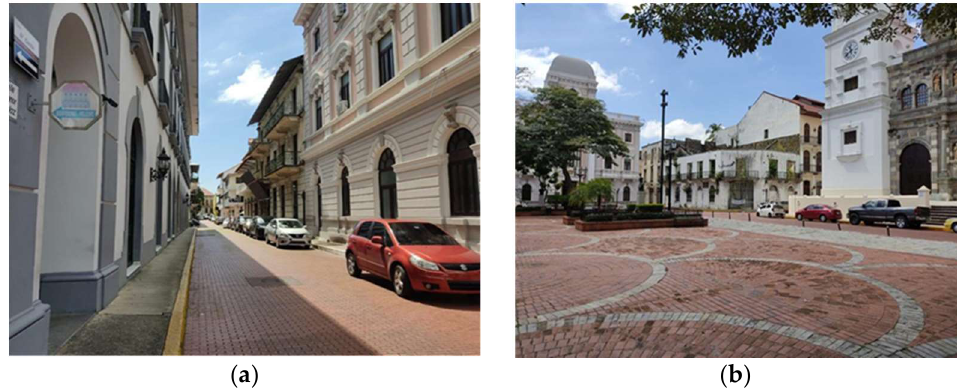
Figure 3. View of the Casco Antiguo: ( a ) streets and ( b ) Square Catedral. Own elaboration.